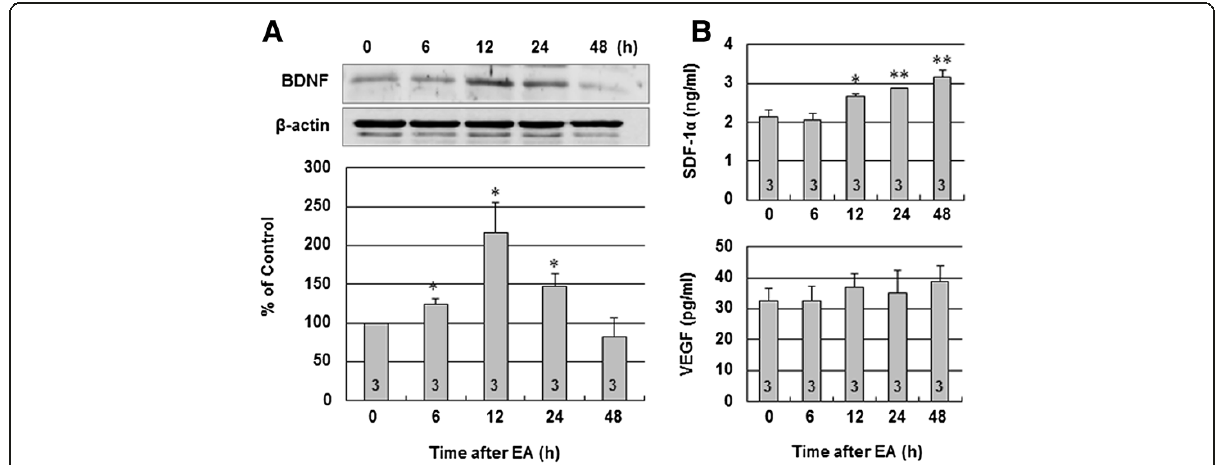
Figure 2 Temporal production of BDNF in the brain tissues and SDF-1 α and VEGF levels in the plasma following EA. (A) Representative western blot of BDNF protein in the cerebral cortex at 0 h (control), 6 h, 12 h, 24 h, and 48 h after the end of EA stimulation. The lower panel shows densitometric analysis of the western blot of BDNF. Relative abundance of BDNF compared with β -actin. (B) Plasma SDF-1 α and VEGF levels in mice at 0 h (control), 6 h, 12 h, 24 h, and 48 h after the end of EA stimulation were analyzed by ELISA. The results are expressed as the mean ± SEM. * , P <0.05 and ** , P <0.01 vs. control. Numbers of mice used for BDNF, SDF-1 α and VEGF measurement are shown on each